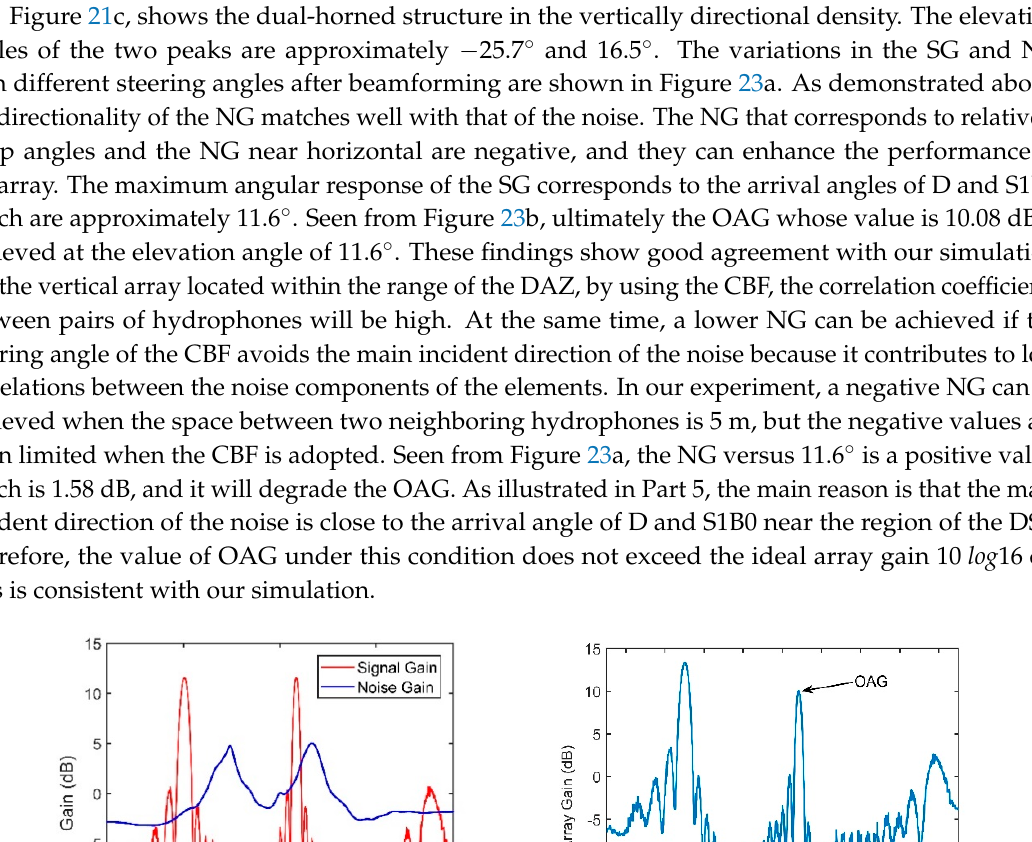
Figure 24. ( a ) Signal waveform; ( b ) Signal frequency through a narrow bandpass filter; ( c ) Beam output of the signal. ( a ) ( b ) ( c ) Figure 25. ( a ) Noise waveform; ( b ) Noise frequency through the 100 Hz to 1 kHz bandpass filter; ( c ) Directionality of the noise. The dual-horned structure in the vertical directional density of the noise can also be seen from Figure 25c, and the elevation angles of the two peaks are approximately − 11.1° and 28.1°. These findings show good agreement with the results in Figure 22.